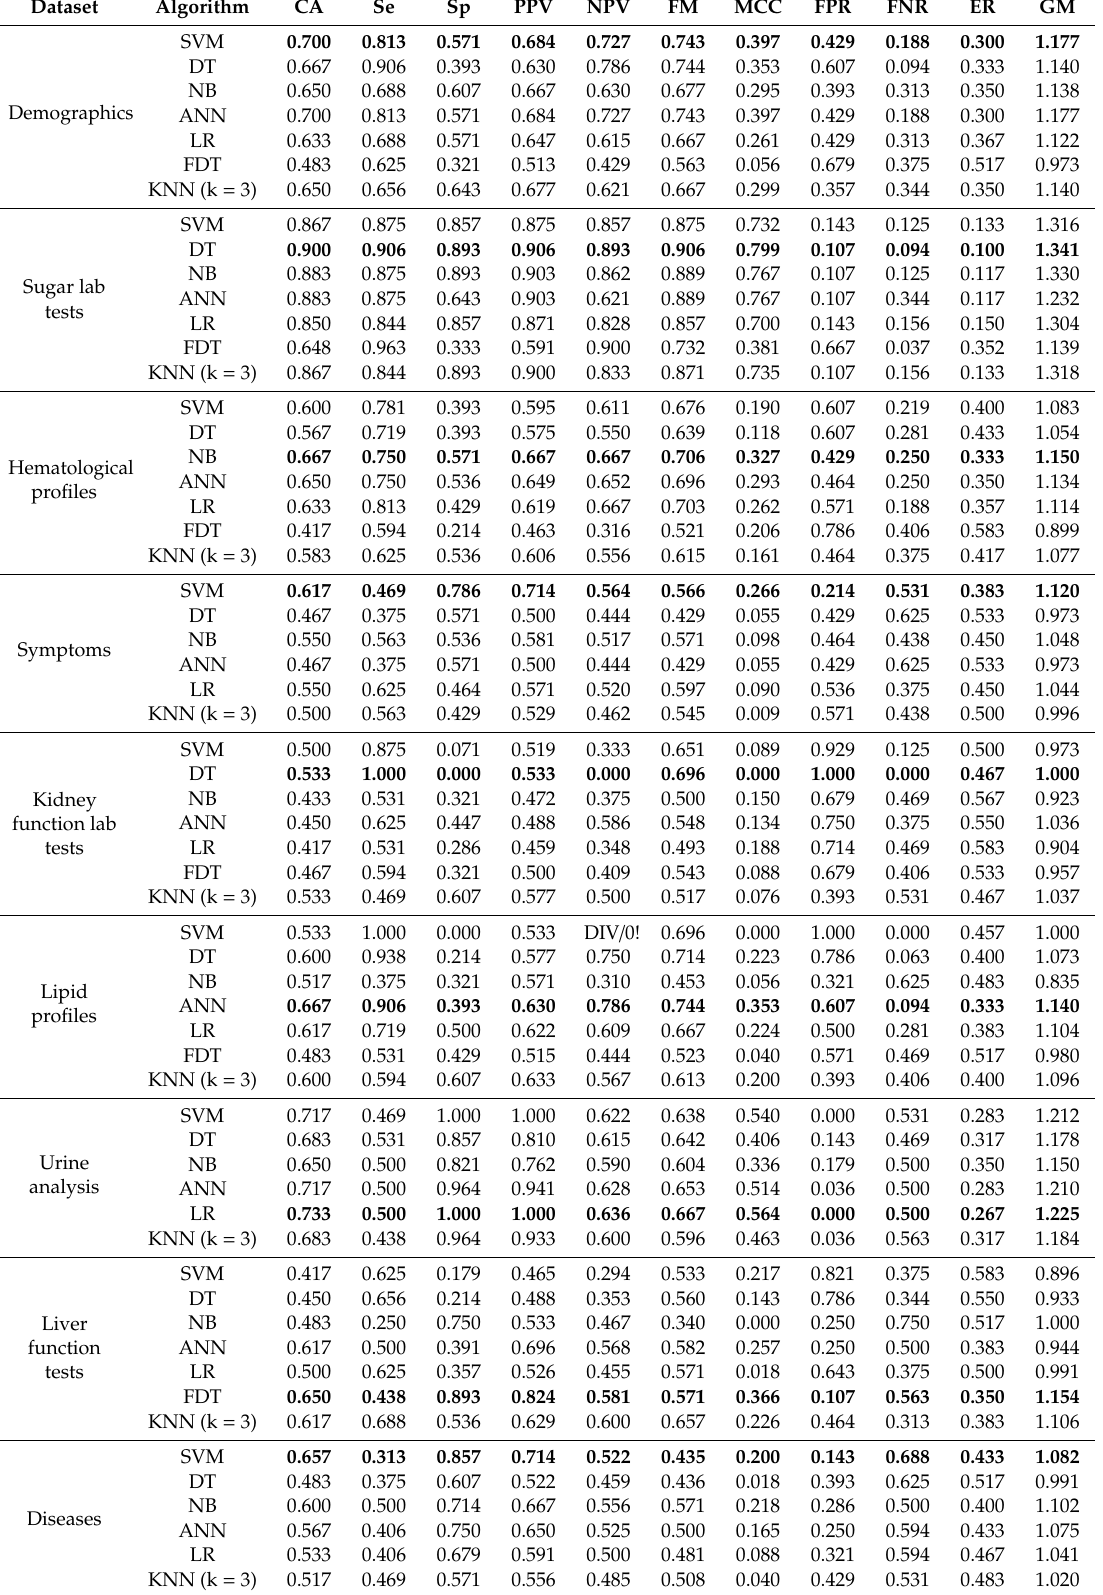
Table 3. The comparison of base classifiers for all datasets using wrapper FS and 10-fold